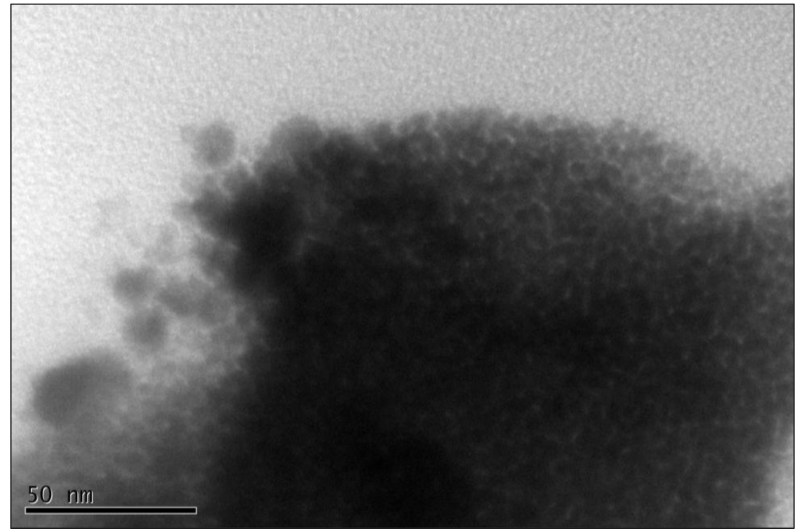
Figure A5. TEM image of fct-FePt of the reference synthesis annealed at 800 ◦ C for 2 h.